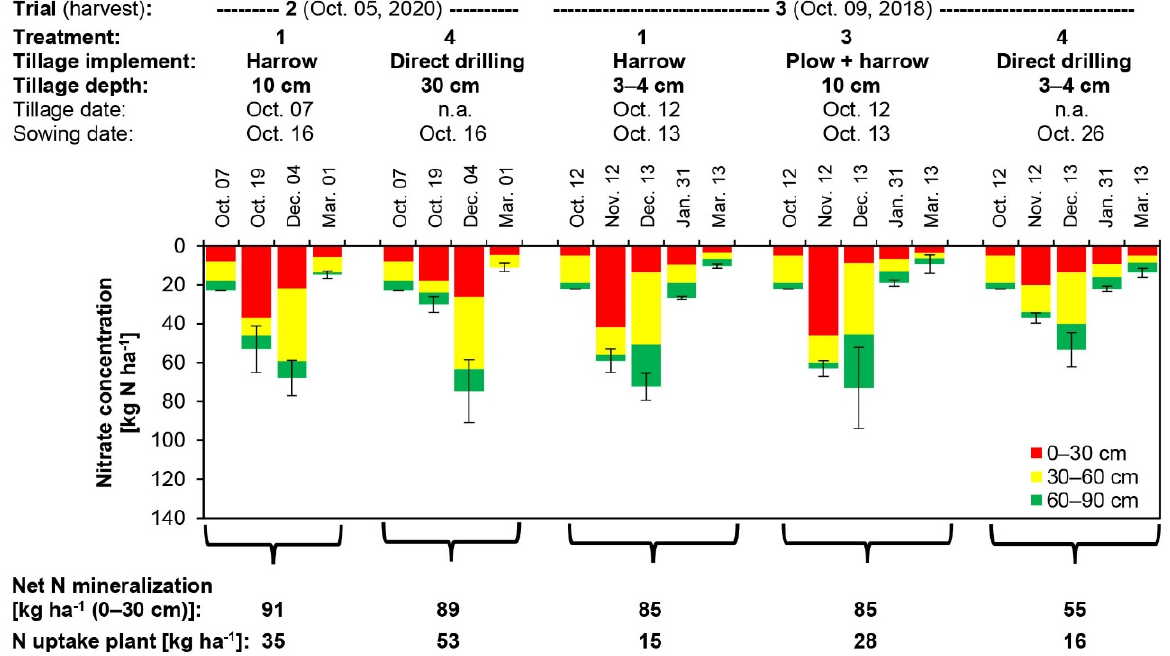
Figure 3. Soil mineral N concentration in the upper soil layers (0–30, 30–60, 60–90 cm) during autumn and winter seasons as well as net N mineralization (0–30 cm) and total N uptake by plants as a function of tillage depth after spinach harvest ( n = 3; Mean ± SD). n.a. = not applicable.